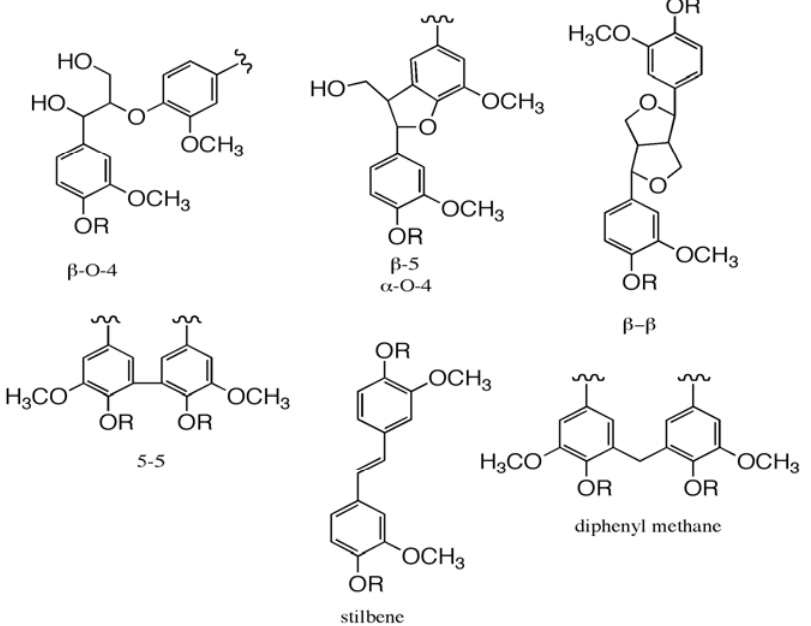
Figure 2. Illustrations of typical softwood lignin structures; β -O-4, β -5, α -O-4, β - β and 5-5, additionally, for residual lignin stilbene and diphenylmethane structures. R=H (non-etherified structure); R = Lignin (etherified